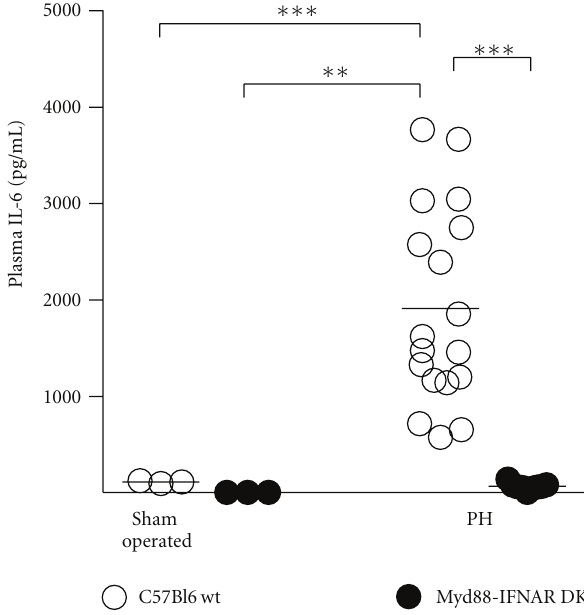
Figure 2: Circulating levels of IL-6 in C57Bl6 WT mice and Myd88-IFNAR double-KO mice after PH or sham laparotomy. Blood samples were obtained from the retroorbital sinus at 4h after surgery, and IL-6 was measured in plasma by ELISA. ∗∗ P < 0 . 01, ∗∗∗ P < 0 .